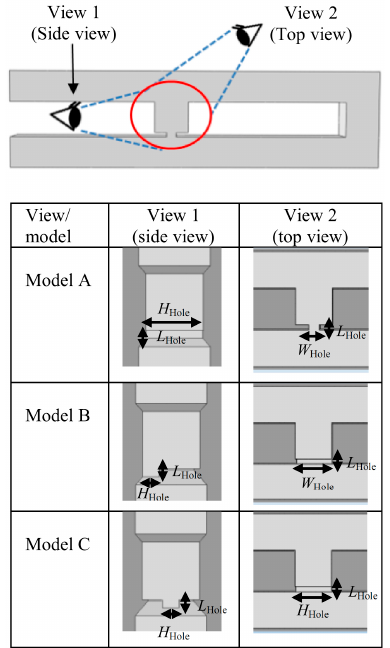
Figure 12. The views for three cell trapping models with the same trap hole size (2, 7 and 7 μ m for W Hole , L Hole , and H Hole , respectively) at different positions.